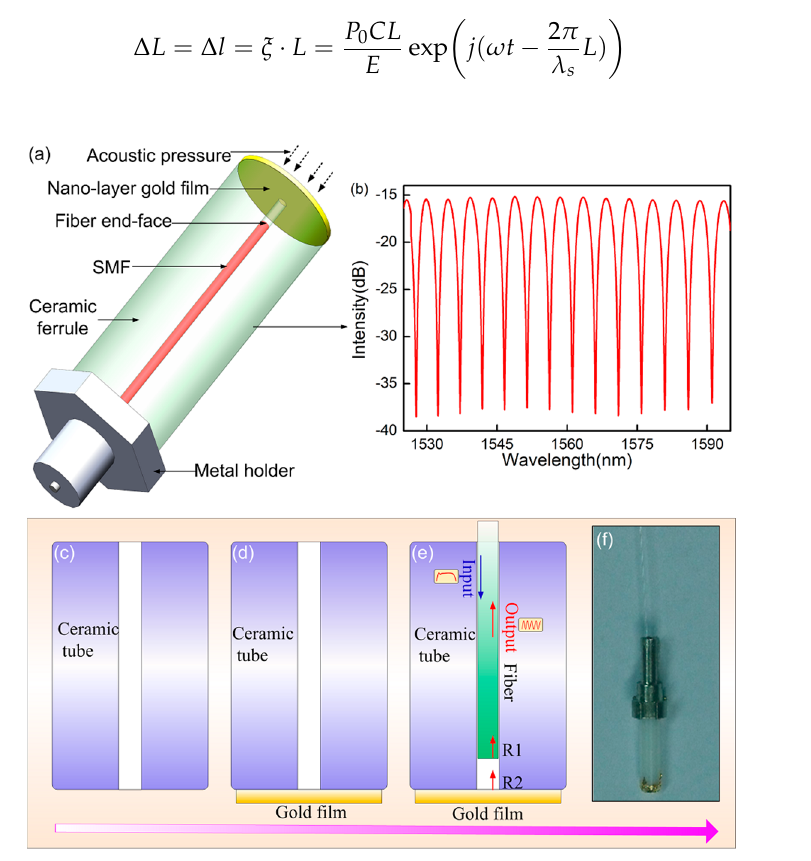
Figure 1. ( a ) Scheme diagram of UW sensor structure; ( b ) interference spectrum of sensor; ( c – e ) sensor fabrication process; ( f ) image of sensor before packaging protection.